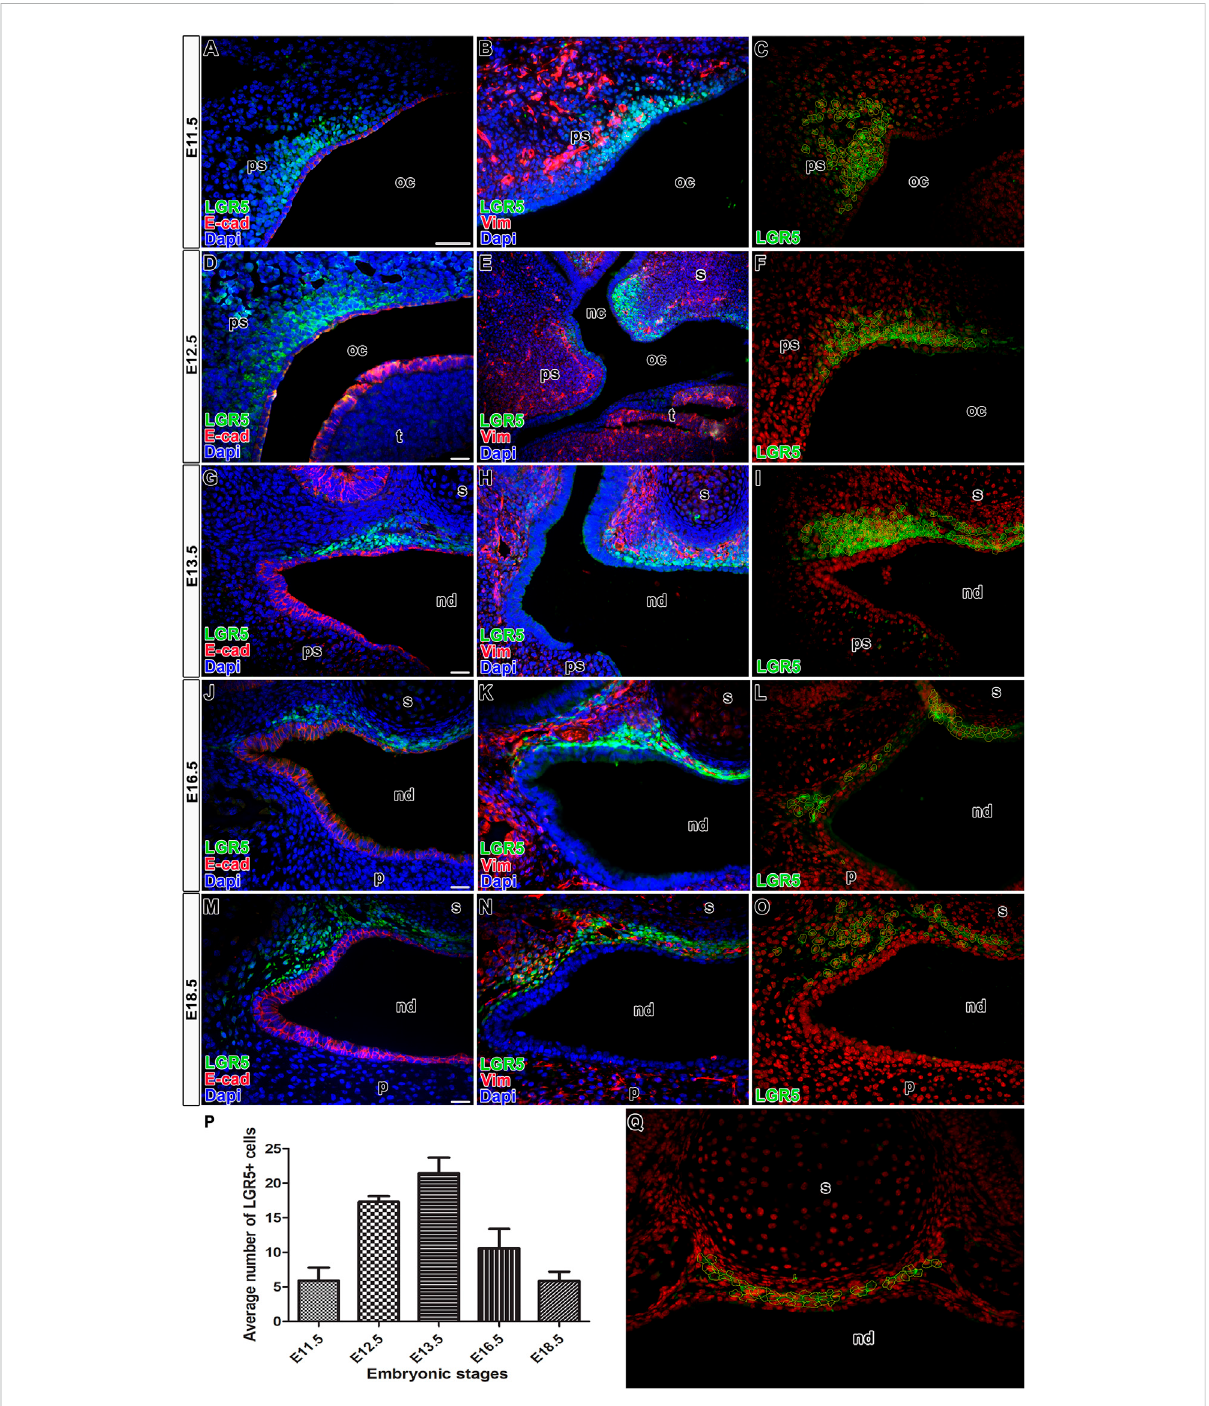
FIGURE 2 Co-expression of LGR5 and epithelial or mesenchymal marker in palatal areas. Transversal sections of mice heads through the nasopharyngeal duct area double stained by anti-EGFP and anti-E-cad as an epithelial marker (A,D,G,J,M) or anti-EGFP and anti-vimentin as a mesenchymal marker (B,E,H,K,N) . There is no overlap of expression of LGR5 (anti-EGFP) and epithelial marker E-cad at E11.5 (A) , E12.5 (D) , E13.5 (G) , E16.5 (J) , E18.5 (M) . Co-expression of LGR5 and mesenchymal marker vimentin is located in the dorsal mesenchyme of forming palatal shelves adjacent to the epitheliumatE11.5 (B) ,inmesenchymesurrounding futurenasopharyngealductatE12.5 (E) ,E13.5 (H) andinthemesenchymesurroundingthenasal septum at E16.5 (K) and E18.5 (N) . Examples of analyzed cell populations of LGR5-positive cells in the nasopharyngeal duct area and underlaying nasalseptum (C,F,I,L,O,Q) .Graphdisplaysquanti fi cation ofLGR5-positivecells innasopharyngeal ductarea (P) .The highestnumberofpositive cells wasobservedatE13.5.nc,nasalcavity;nd,nasopharyngealduct;oc,oralcavity;p,palate;ps,palatalshelve;t,tongue;s,septum.Scalebars=100 μ